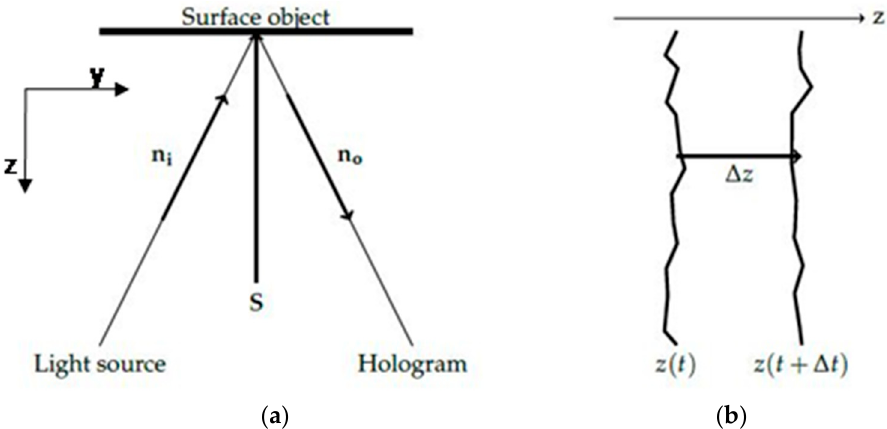
Figure 3. ( a ) Surface illumination configuration and observation, and ( b ) main surface displacement direction .